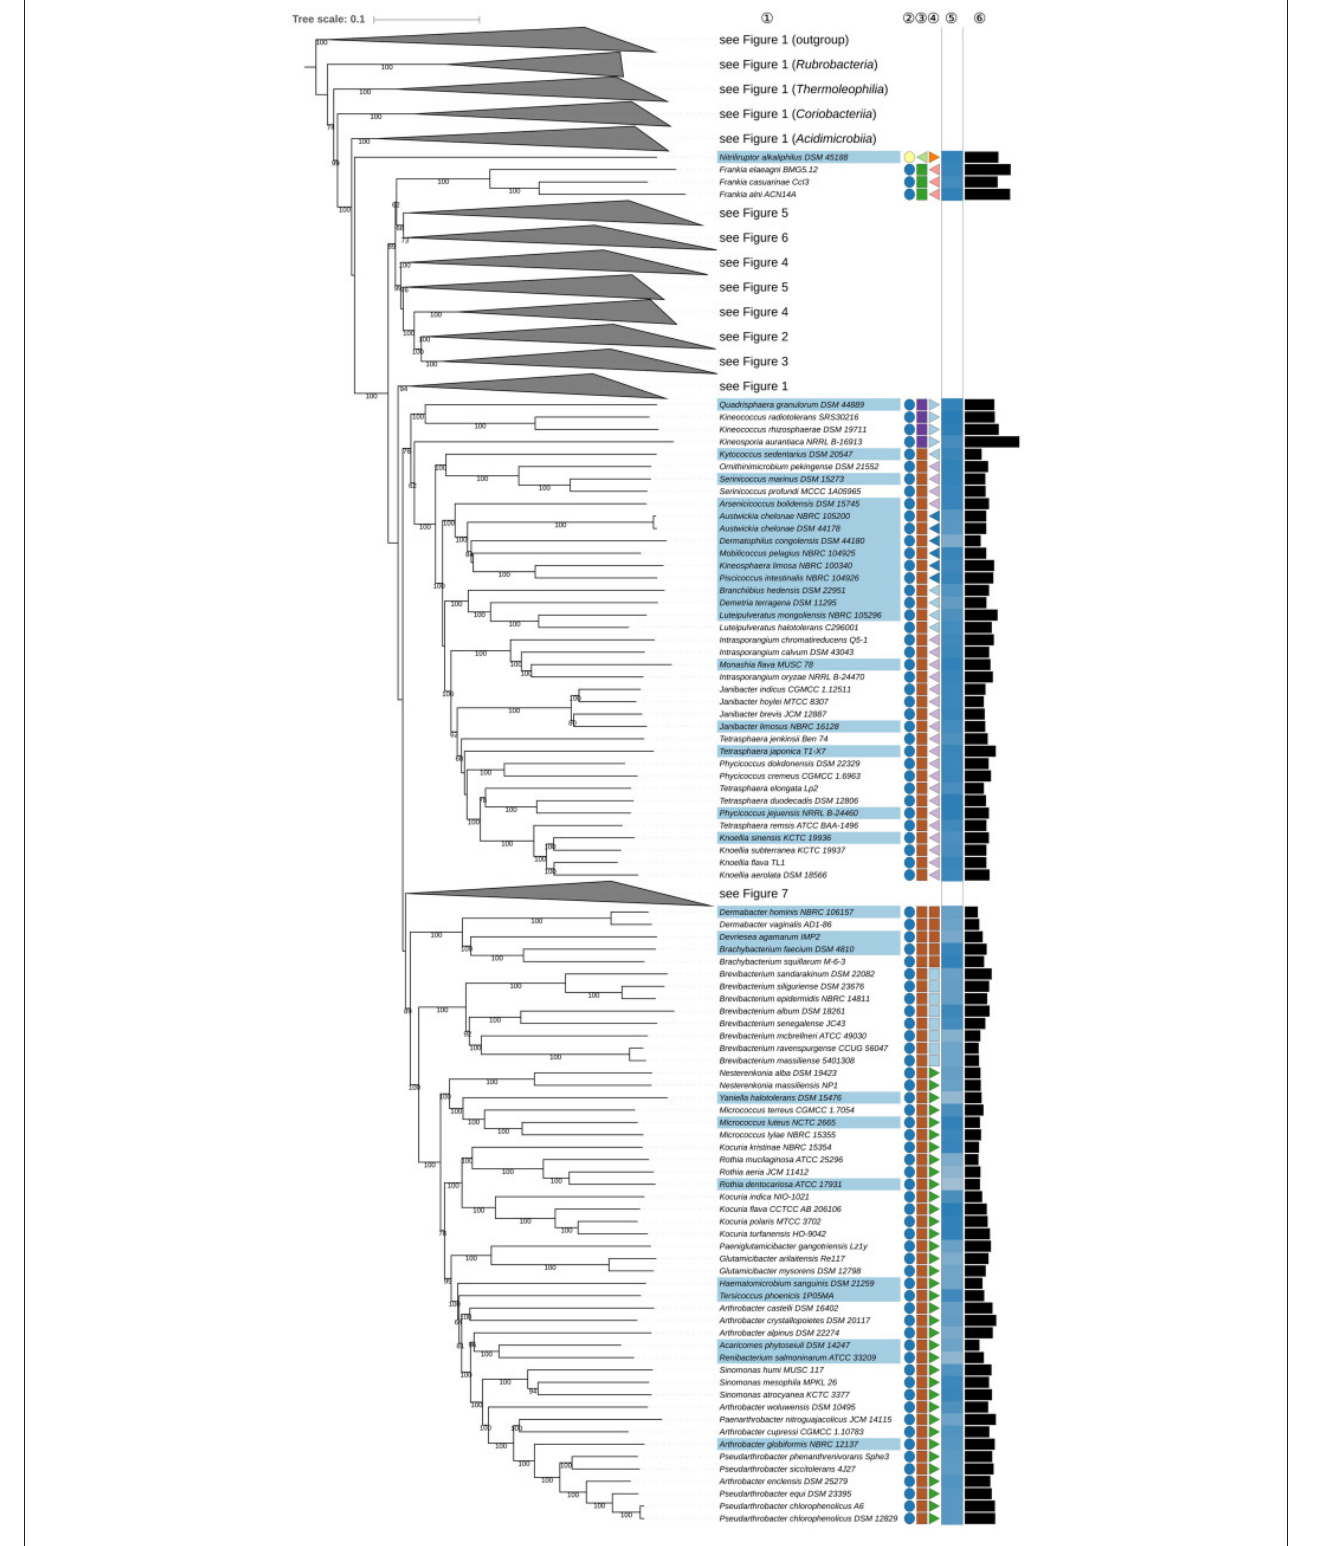
FIGURE 8 | Eighth part of the phylogenomic tree inferred with GBDP. A detailed description is provided in the caption of Figure 1 . The parts of the tree which have been collapsed here are shown in other figures as indicated.